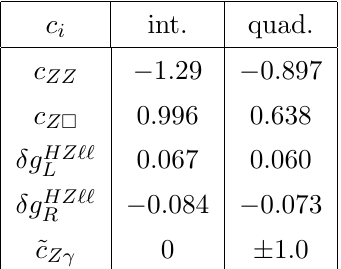
2 e 2 (cid:22) partial decay width by !